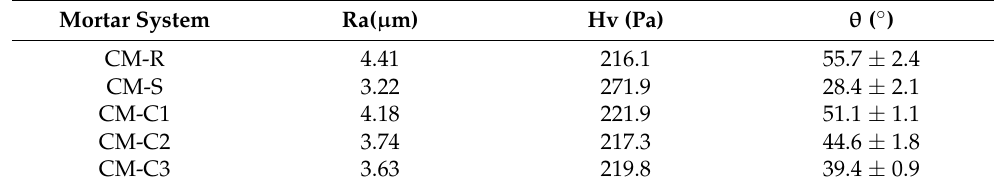
Table 1. Performance indexes of mortar samples with and without TiO 2 @CoAl-LDH nanospheres after curing for 28 days. Mortar